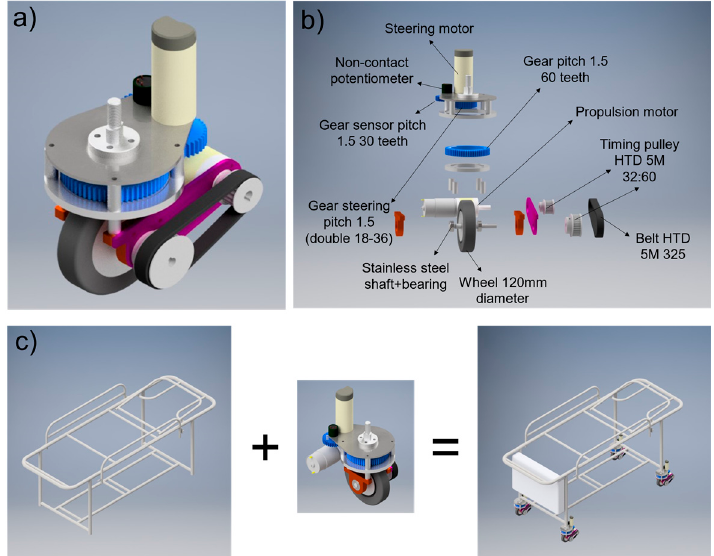
Figure 1. ( a ) Swerve drive module; ( b ) Exploded view of the swerve drive module showing its major parts; and ( c ) Concept of the modification of usual hospital beds into motorized ones by adding the swerve drive module.